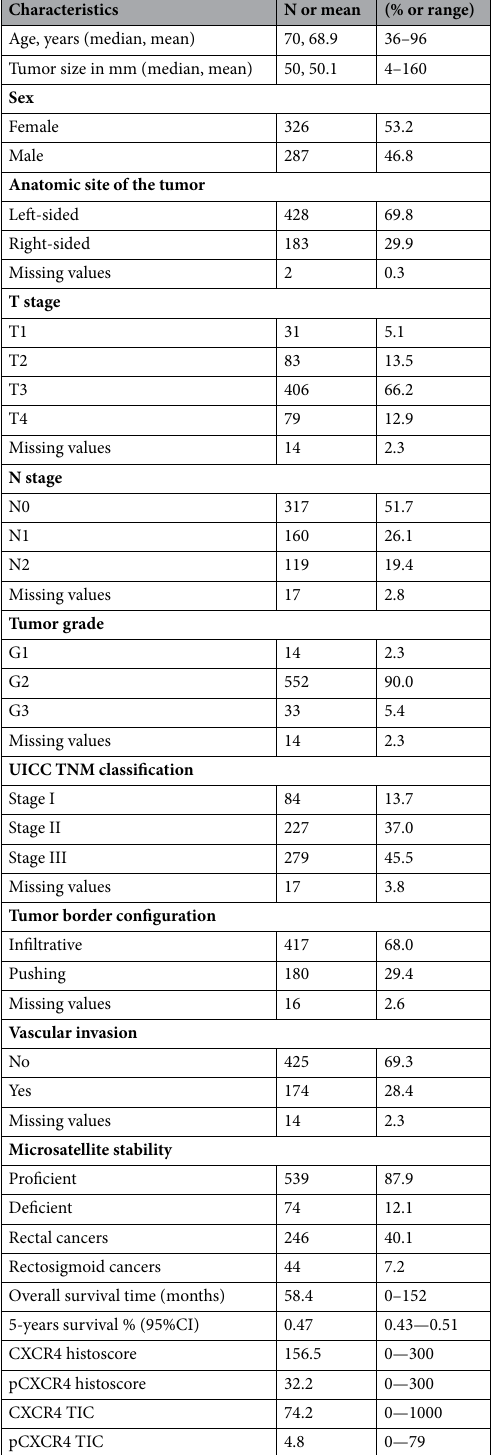
Table 1. Characteristics of CRC patient cohort (n = 613). Age and tumor size were evaluated using the Kruskal–Wallis test. Gender, anatomical site, T stage, N stage, grade, vascular invasion, and tumor border configuration were analyzed using the χ 2 test. Survival analysis was performed using the Kaplan–Meier